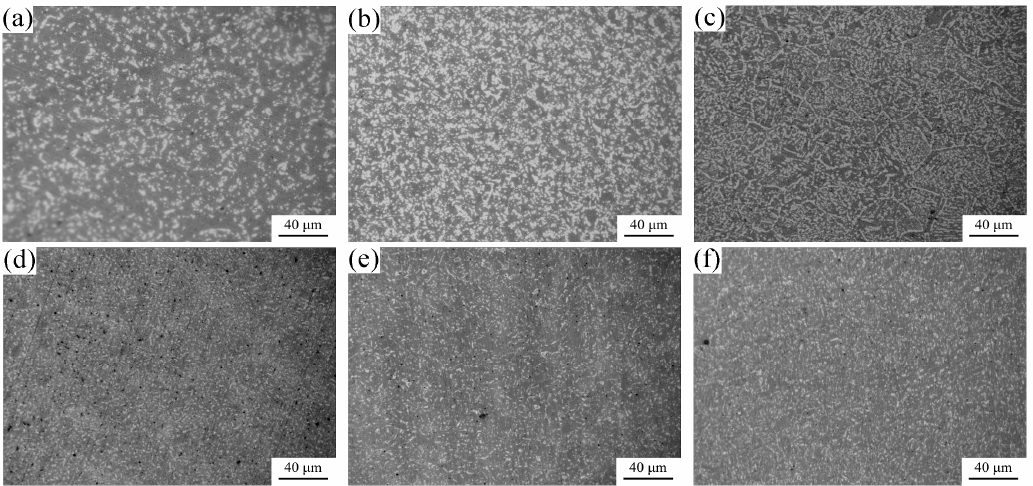
Figure 6. M/A constituent observations of the samples reheated at different temperatures (990 °C ( a ); 1030 ( b ); 1080 ( c )) before tempering and after tempering at 550 °C (reheated at 990 °C ( d ); 1030 °C ( e ); 1080 °C ( f )).